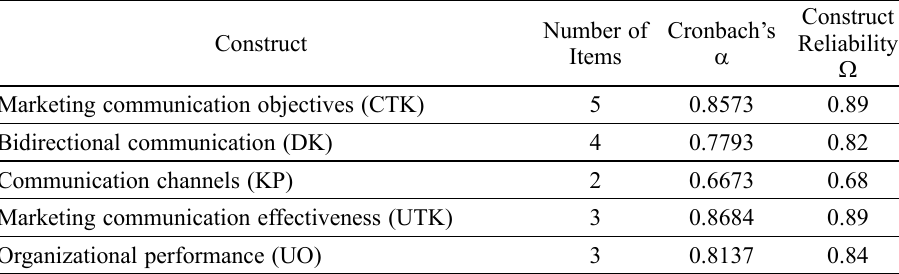
Table 1. Reliability